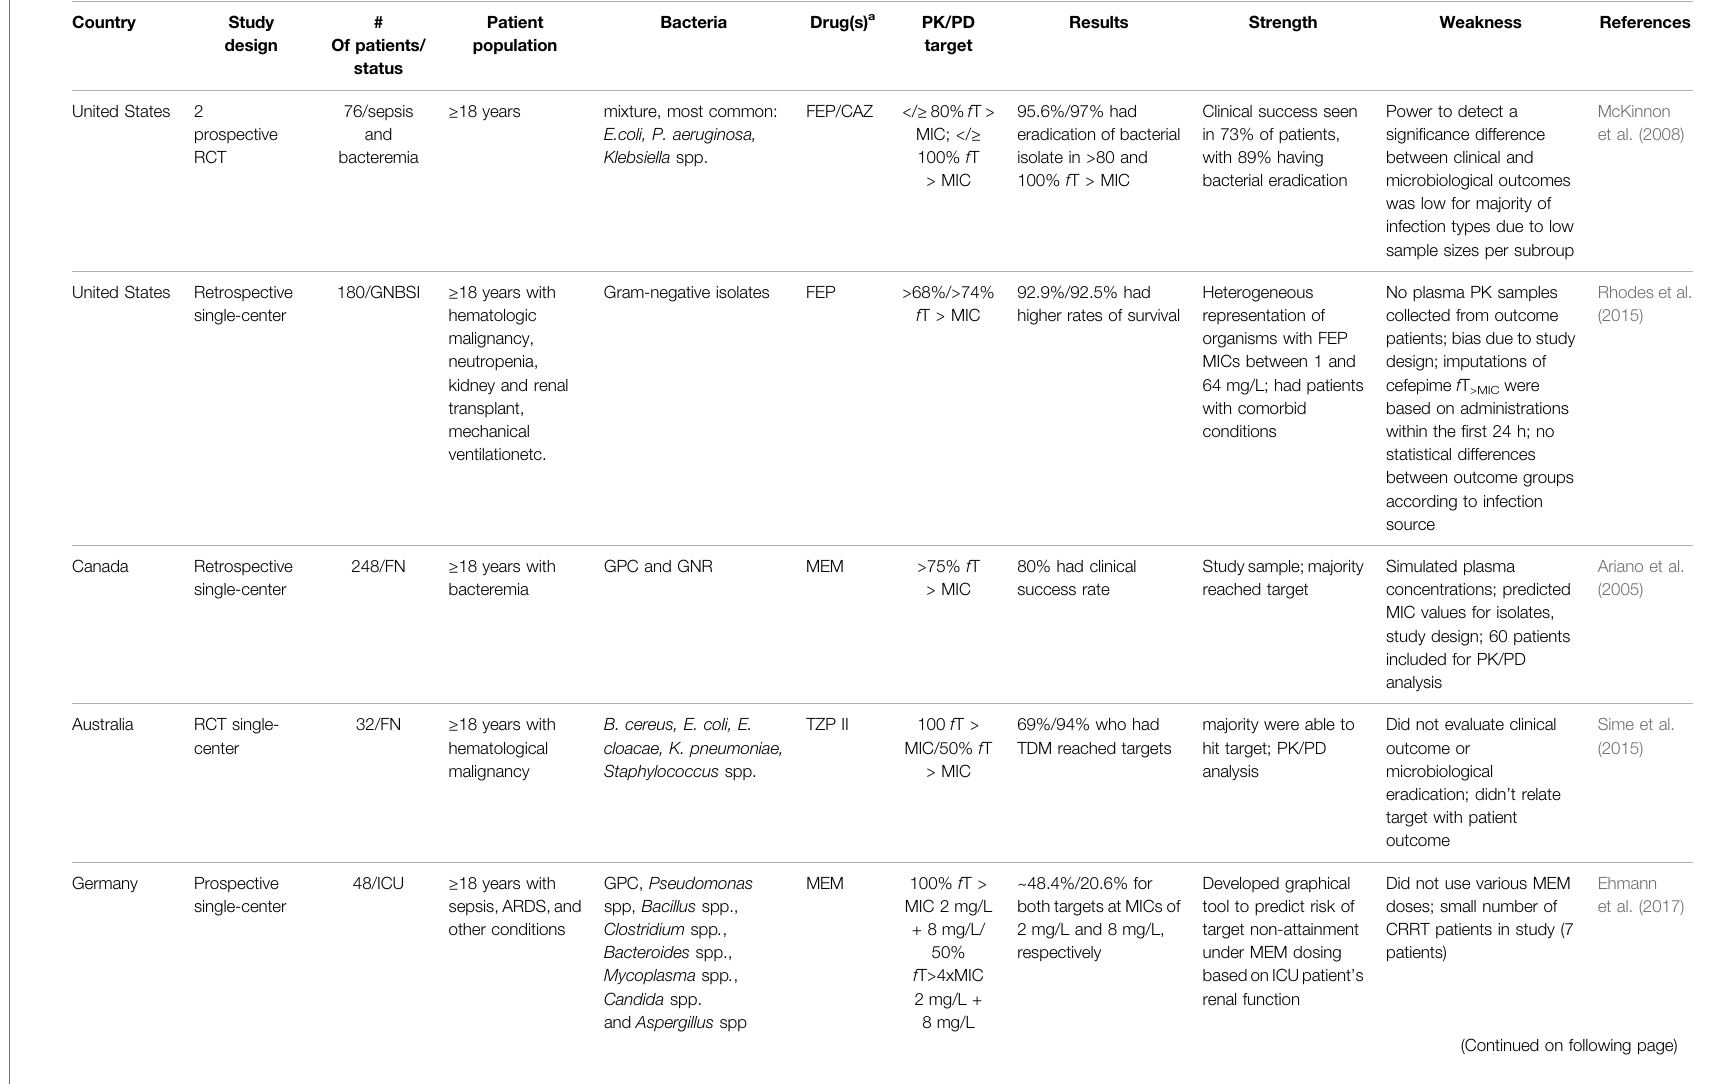
TABLE 1 | Summary of details for clinical pharmacodynamic studies of